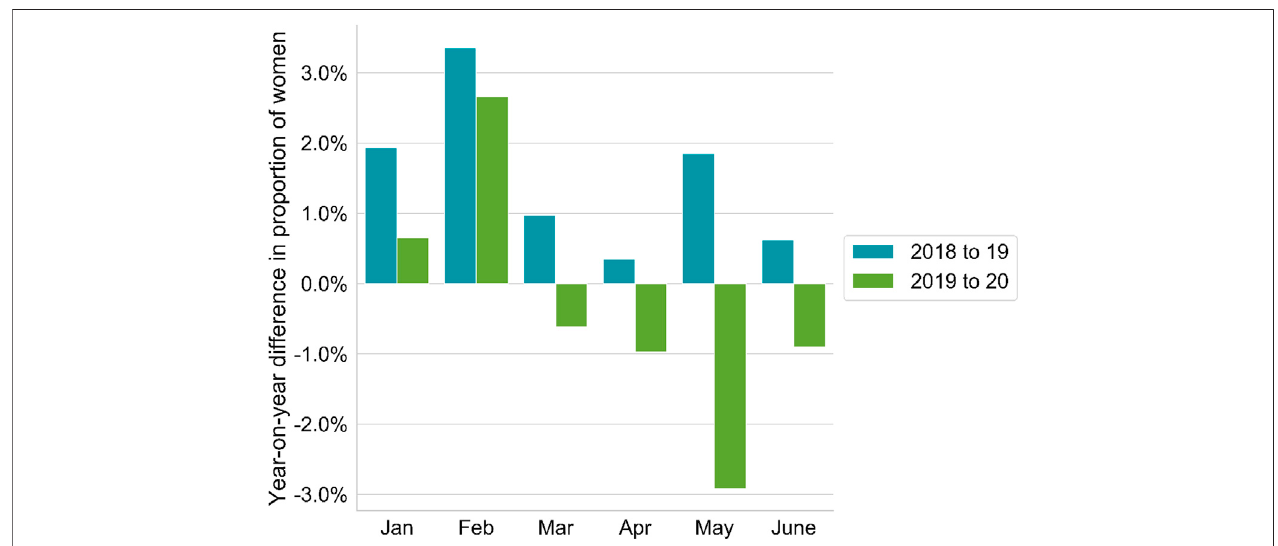
FIGURE 12 | Annual comparison of the progression of female fi rst-position co-authorships on global output. The bar chart shows the percentage change in the number of women appearing as co-authors on papers in global output. Gender of co-author is determined using a gender guessing algorithm. A co-author is classi fi ed asawomaninthecasethatthealgorithmindicatesacon fi dencelevelofmorethan80%.NotethatthisplotisnotlimitedtoCOVID-relatedpublicationsandiscarriedout onallpublicationswithapublicationdateinthemonthinquestion.Thebluebarsshowthepositivetrendtowardagreaternumberoffemale fi rstauthorpapersfrom 2018 to 2019. The green bars show the less favourable trend from 2019 to 2020 as the increase in the number of female fi rst-authors at fi rst slowed in January and Febrary 2020 and then declined at an increasing rate in March, April and